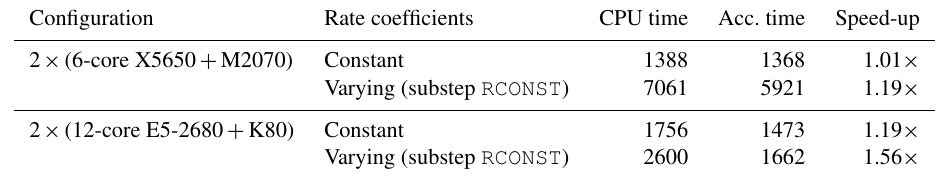
Table 5. Application execution time in seconds and achieved speed-up with/without recalculation of RCONST at each KPP